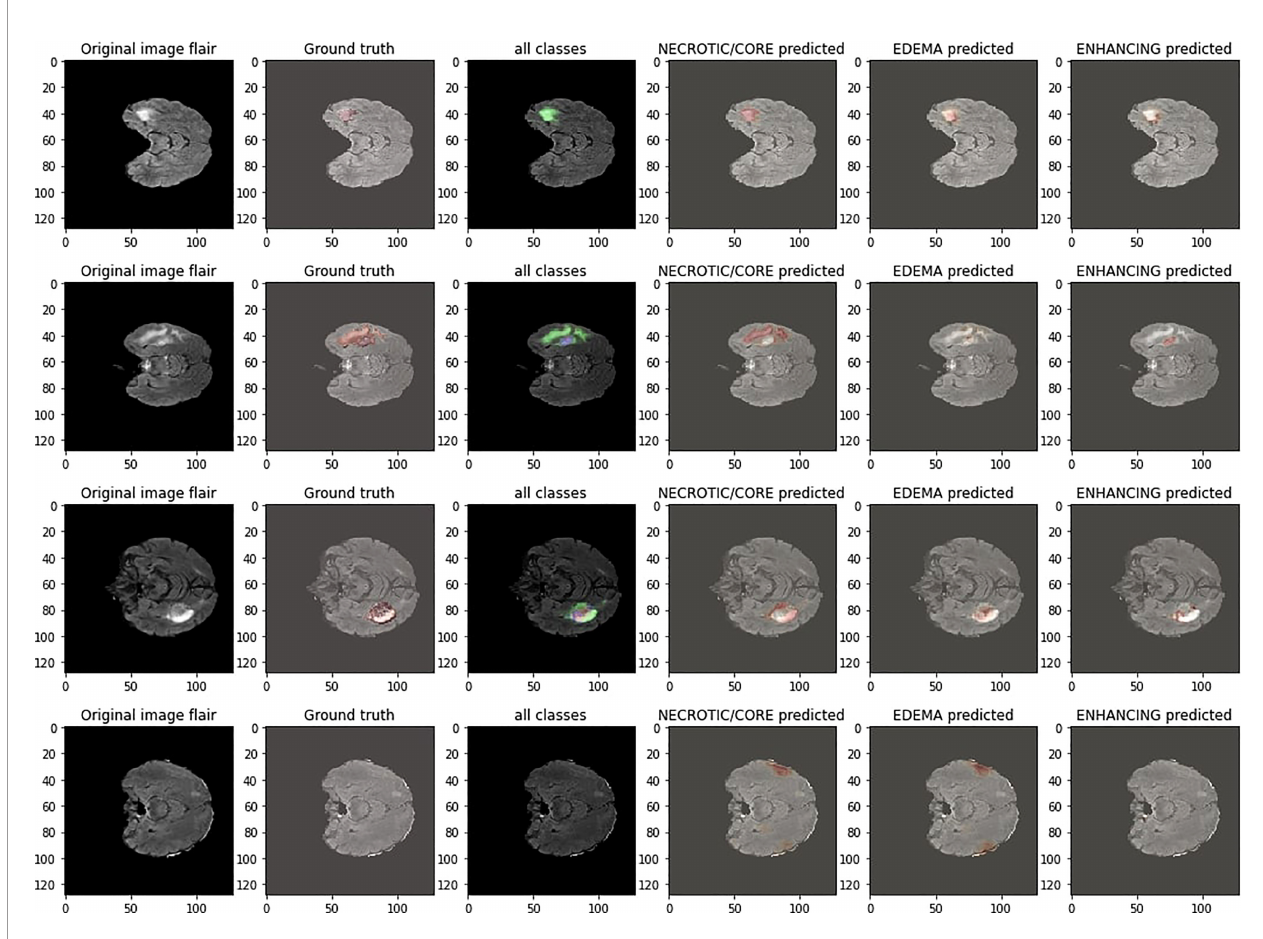
FIGURE 5 | Qualitative results of the proposed framework.